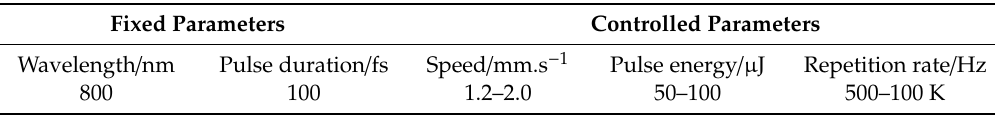
Table 2. The processing parameters applied for fs laser